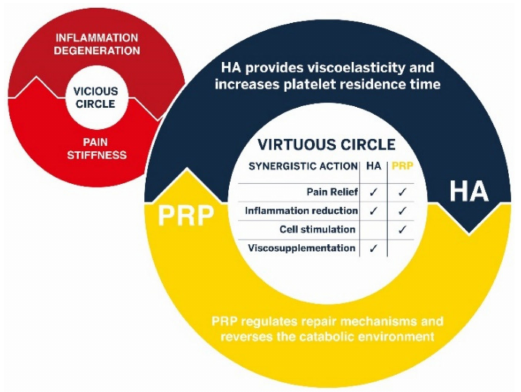
Figure 4. Complementary mechanisms of action of HA and PRP provide synergistic benefit for the treatment of osteoarthritis and other degenerative joint